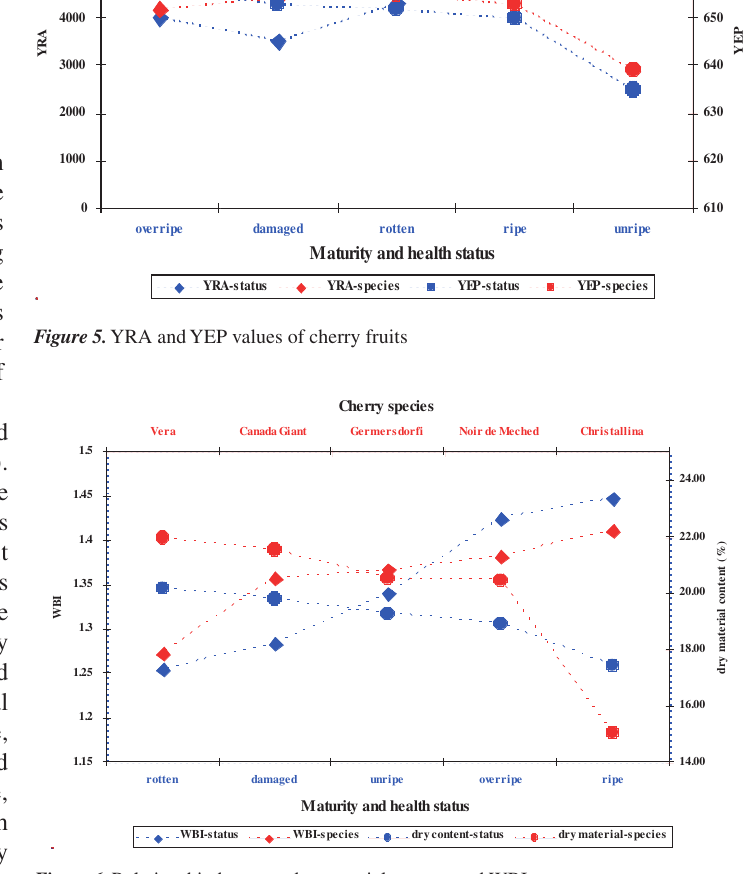
Figure 6. Relationship between dry material content and WBI